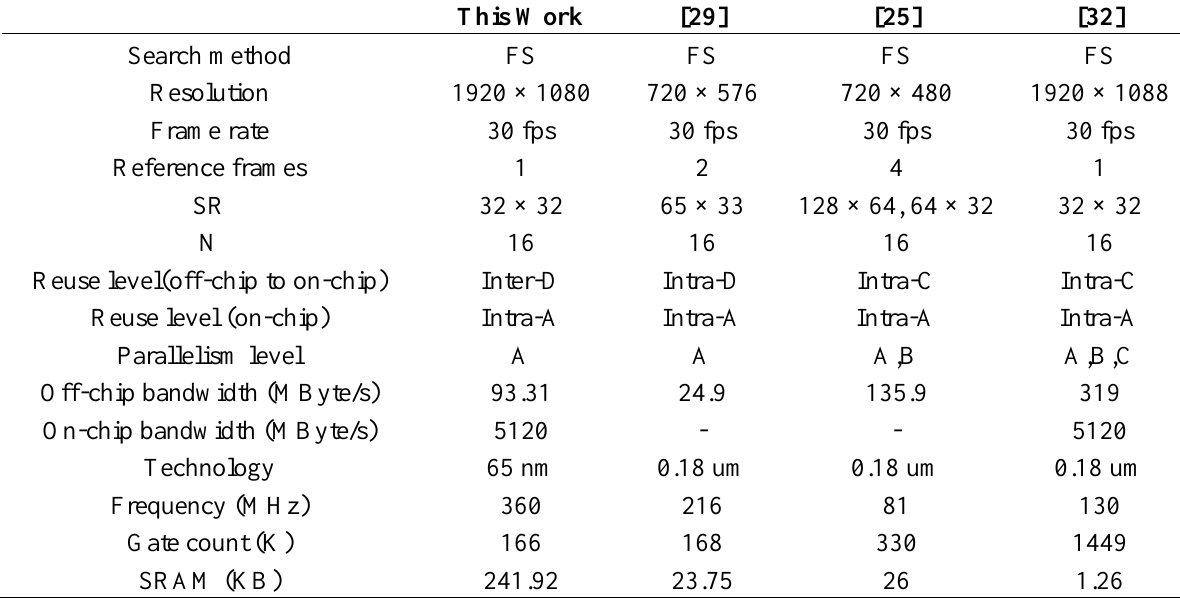
Figure 19. The implemented architecture for IME. Table 6. Comparison between Different FSIME Implementations. This